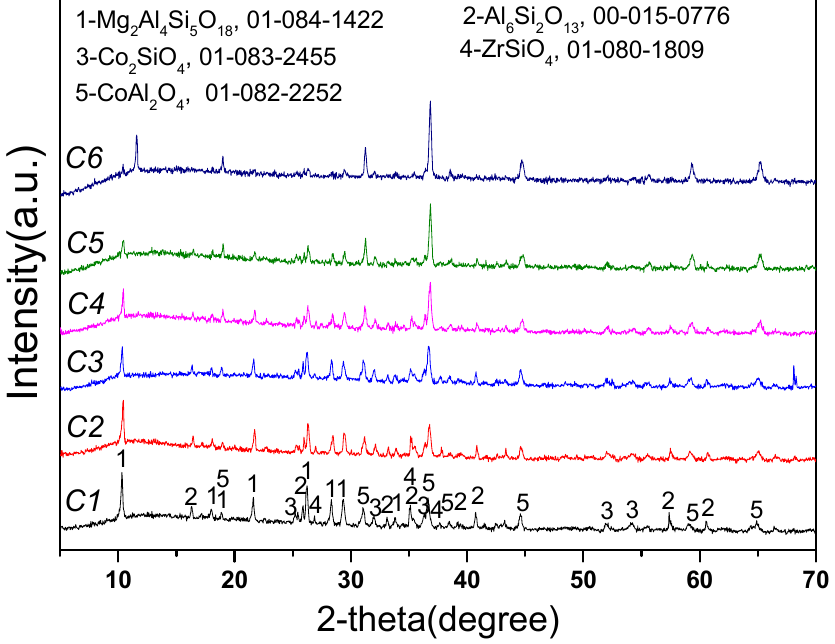
Figure 9. XRD spectra of the corrosion reaction of saggar powder with different contents of cobalt tetroxide.